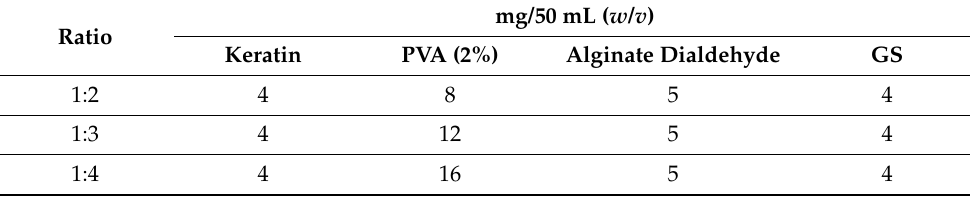
Table 2. Formulation of